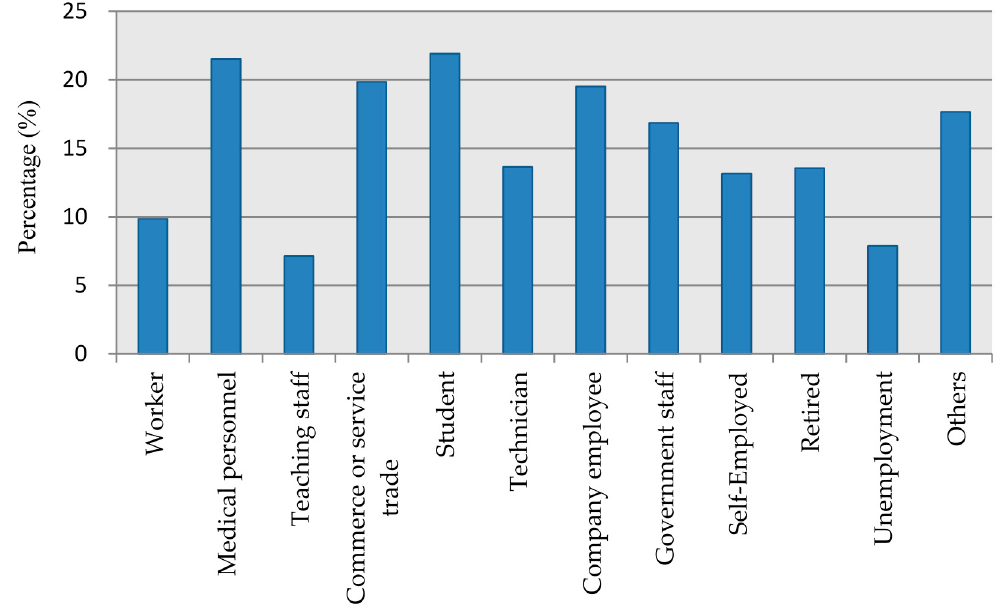
Figure 3. Percentage of respondents who self-reported that they were aware of the health co-benefits in relation to GHG reductions among different occupations.